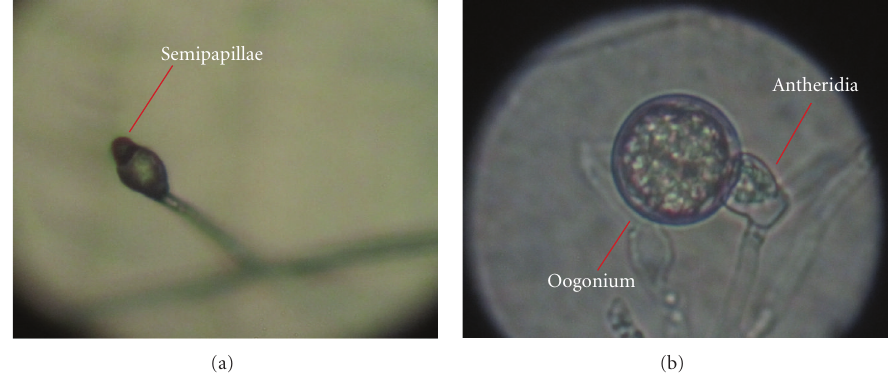
Figure 2: Phytophthora infestans , (a) lemon shape sporangia, (b) amphigynous antheridia of oospores.